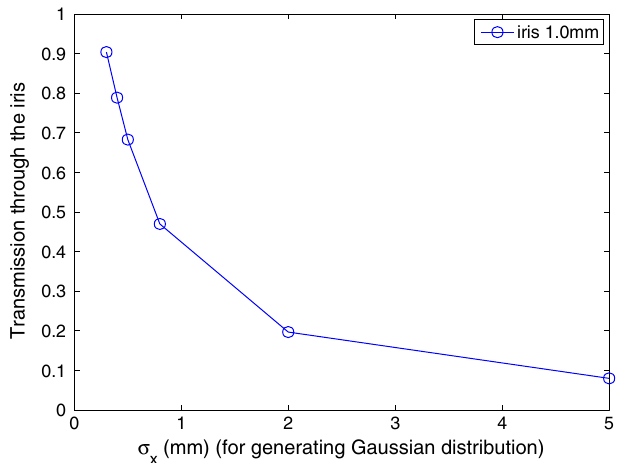
FIG. 4. Calculated laser transmission through the iris for dif- ferent laser beams: the pure uniforms ( (cid:2) x ¼ 5 : 0 and 2.0 mm), nearly uniform ( (cid:2) x ¼ 0 : 8 mm ), and different truncated- Gaussian spatial beams ( (cid:2) x ¼ 0 : 5 , 0.4, and 0.3